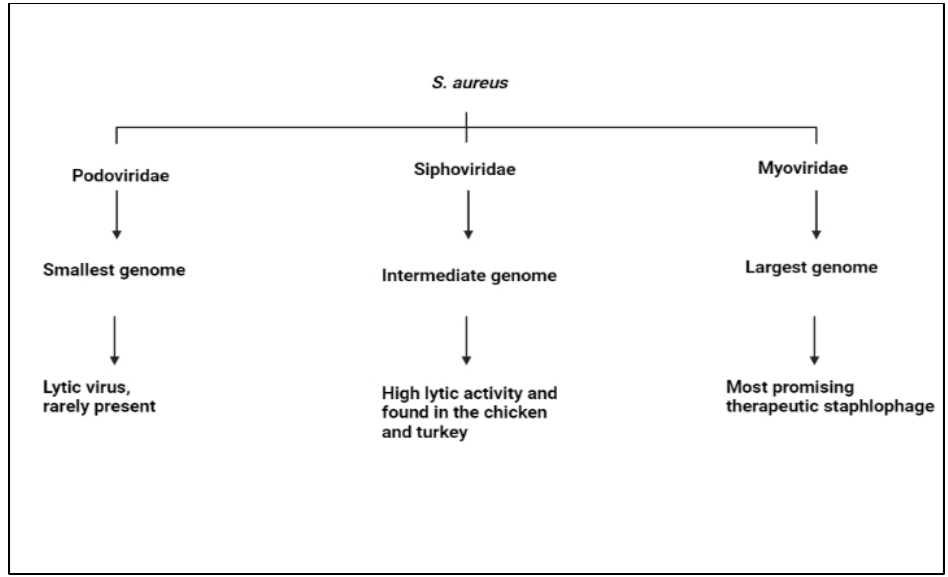
Figure 4. S. aureus has three staphylophages. Podoviridae has the smallest genome, lytic virus, but it is rarely present. Siphovidae has an intermediate genome and high lytic activity, and it is found in chicken and turkey. Myoviridae has the largest genome and is the most promising therapeutic staphylophage.